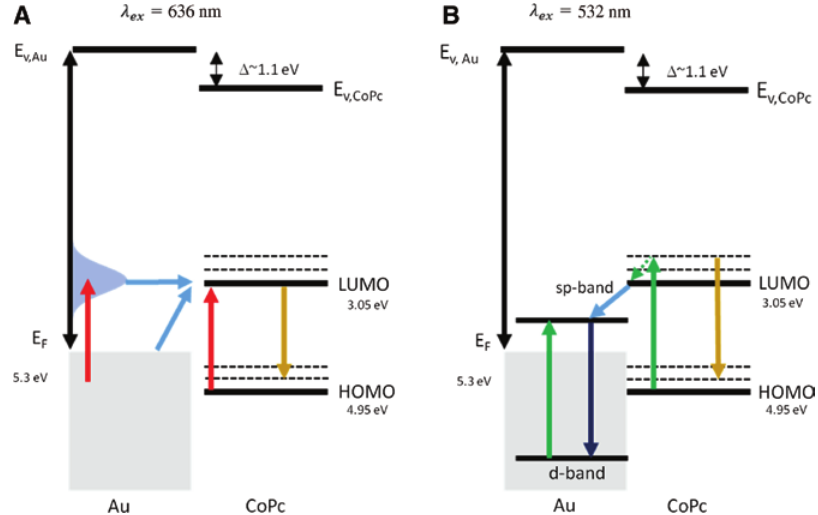
Figure 6: Energy diagram at the interface between Au and the CoPc molecule. (A) The different excitation and charge-transfer process occurring at 636 nm excitation. On the left side, only the hot electron population (shown as a blue peak) in Au is excited by the 636 nm laser irradiation. On the right side, the HOMO-LUMO transition in CoPc is resonantly excited by the 636 nm laser. The two blue arrows indicate the possible photo-induced metal-to-molecule charge-transfer processes. The horizontal blue arrow shows the charge transfer from the hot electron population to the LUMO of the CoPc molecule. The diagonal blue arrow indicates the charge-transfer process from the Au Fermi level directly to the LUMO of the CoPc molecule. The downward-pointing brown arrow represents the Raman scattering process. (B) The excitation, emission, and charge-transfer process occurring at 532 nm excitation. The green arrows refer to either the d-sp interband transition in Au or the molecular excitation of CoPc. The downward-pointing dashed green arrow indicates the nonradiative relaxation. The downward-pointing dark-blue arrow indicates the radiative relaxation in Au. The blue arrow indicates the possible photo-induced molecule-to-metal charge transfer. The downward-pointing brown arrow represents the Raman scattering